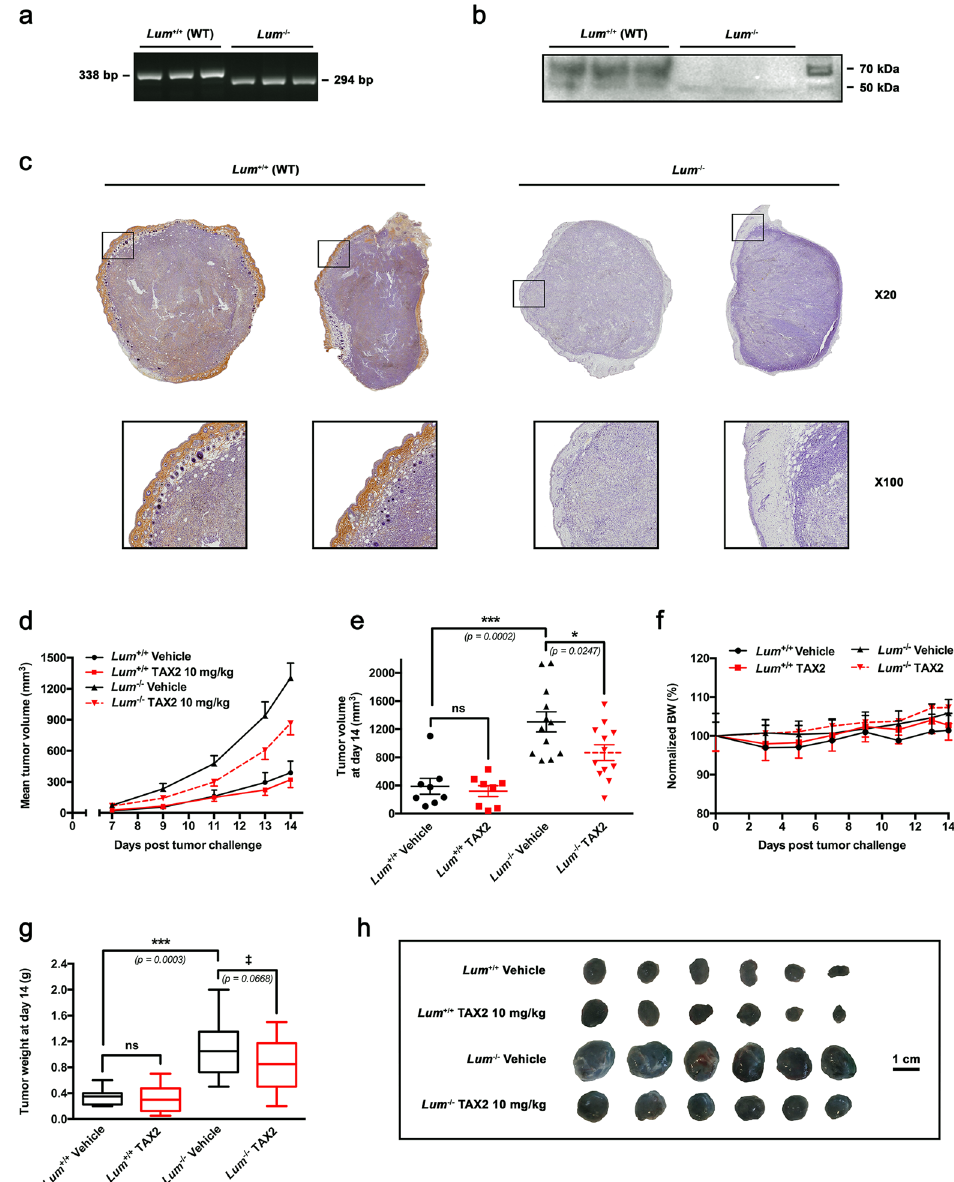
Figure 2. Evaluation of endogenous lumican impact on tumor growth and response to TAX2 treatment in a melanoma allograft model. ( a ) Genotype of representative offsprings from wild type ( Lum + / + ) matings and lumican deficient ( Lum − / − ) matings by PCR analysis. ( b ) Western immunoblotting on total protein extracted from skin of wild type ( Lum + / + ) mice ( n = 3) and lumican-deficient ( Lum − / − ) mice ( n = 3) with a rabbit polyclonal antibody raised against lumican core protein. Protein extracts from wild type mice exhibit a broad band at 57–90 kDa indicating the presence of glycosylated lumican as expected. Skin from lumican-deficient ( Lum − / − ) animals lacks any immunoreactive material confirming the absence of any lumican gene product. ( c – h ) B16F1 melanoma cells (2.5 × 10 5 ) were s.c. inoculated in Lum + / + or Lum − / − syngeneic C57BL/6 J mice, and then i.p. administrations of either Vehicle (0.9% NaCl) or TAX2 peptide (10 mg/kg) were performed on days 3, 5 and 7 post tumor cells inoculation. On day 7, tumors were detectable and tumor volume was measured every 1–2 days as described in Materials and Methods. ( c ) Microscopic views of s.c. allograft whole sections IHC ( top panel , × 20) allowing visualization of lumican within tumors implanted in wild-type ( Lum + / + ) mice while it is neither detected in tumors from Lum − / − animals. Insets show higher magnification ( × 100) of stromal margin surrounding melanoma allografts. ( d ) Averages of calculated tumor volumes in mm 3 (mean ± SEM, n = 8–12 per group). ( e ) Scatter dot plot of individual calculated tumor volumes on day 14. Line , mean ± SEM ( t test, ns not significant, * p < 0.05, *** p < 0.001). ( f ) Evolution of normalized mice body weights (BW), expressed as a percentage of day 0 (mean ± SEM). ( g ) Tukey’s box and whisker plots of isolated tumor weight in g. Significant ( *** p < 0.001) as well as marginally significant ( ‡ p < 0.10) differences between groups are indicated ( t test). ( h ) Representative photographs of B16F1 melanoma s.c. allografts after tumor